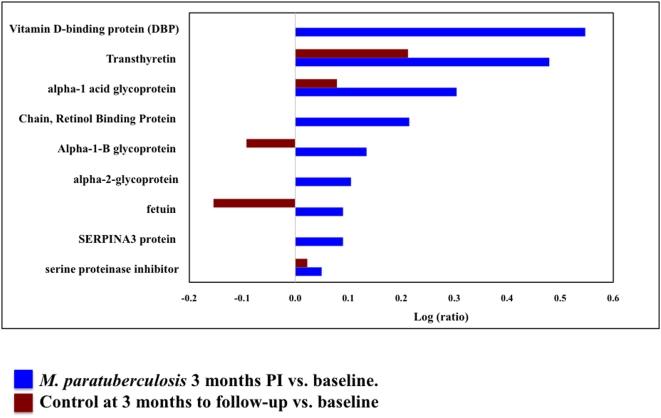
Biomarkers identified in early M. paratuberculosis infection.This bar graph represents log ratios of serum proteins (P-value<0.05, EF<2) identified in early (3-months to follow-up) M. paratuberculosis infected vs. control animals. The blue bars represent log ratios of proteins in animals infected with M. paratuberculosis over time (3 months PI vs. baseline). The red bars represent log ratios of the same proteins in control animals over time.